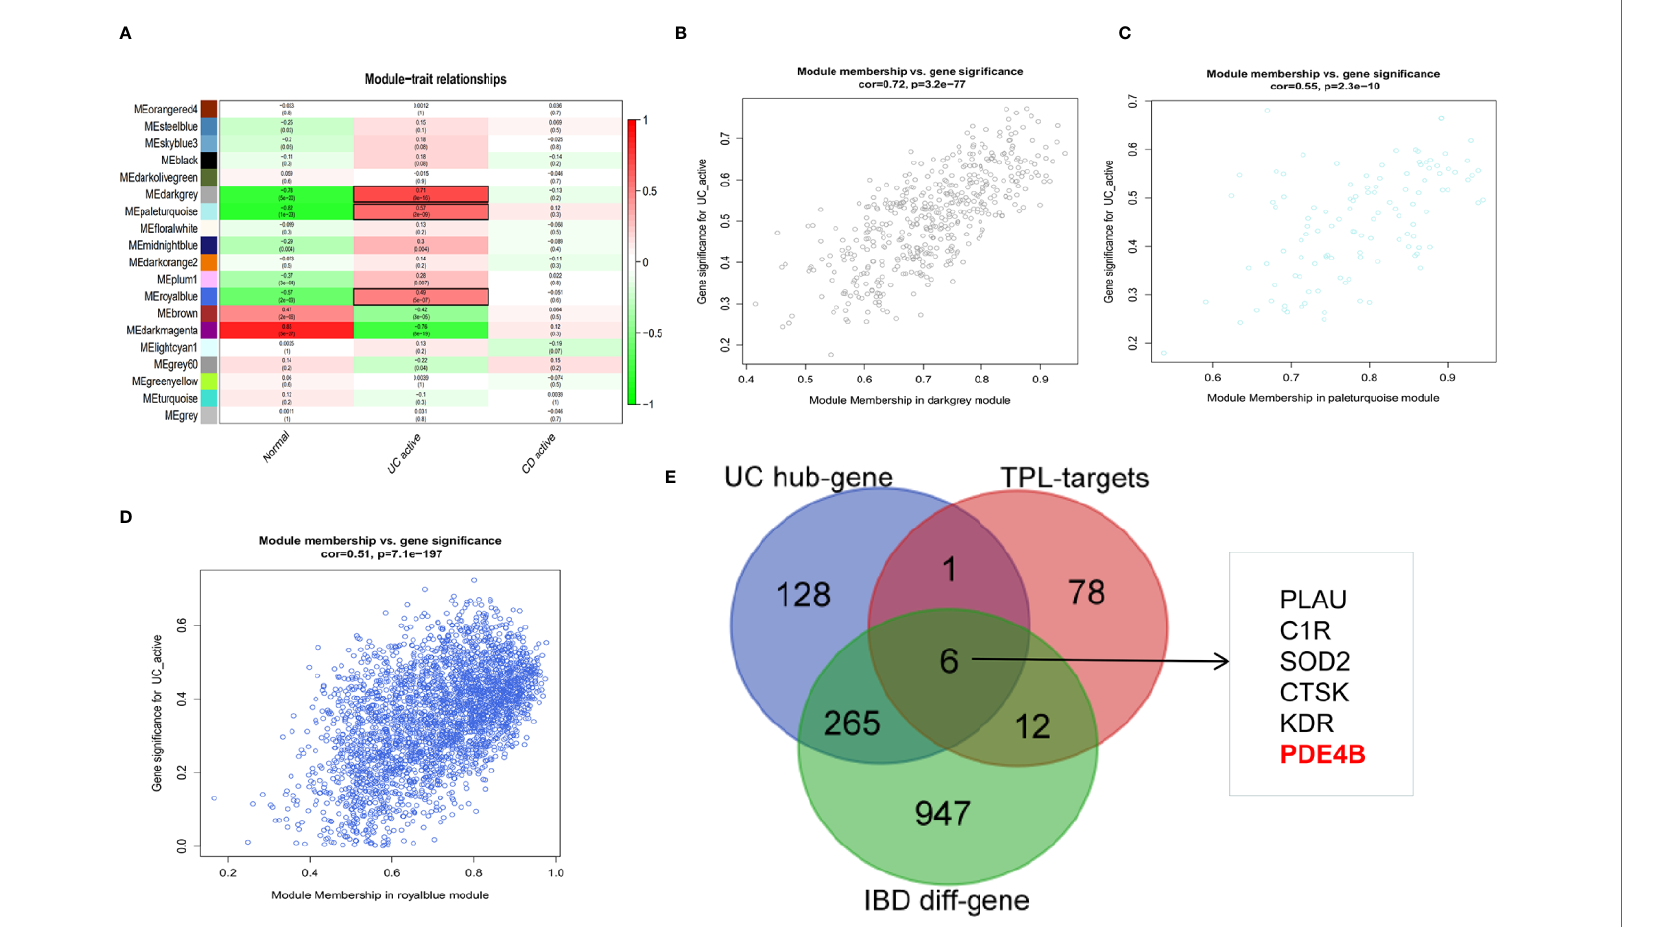
FIGURE 5 | WGCNA was used to identify IBD-associated modules and hub genes in in fl ammatory bowel diseases. The co-expressive modules of IBD are depicted (A) . The correlation coef fi cient and p-value of (B) “ dark gray ” , (C) “ pale turquoise ” , (D) “ royal blue ” modules is shown (B – D) . (E) The Venn diagram shows the underlying molecules of triptolide in intestinal in fl